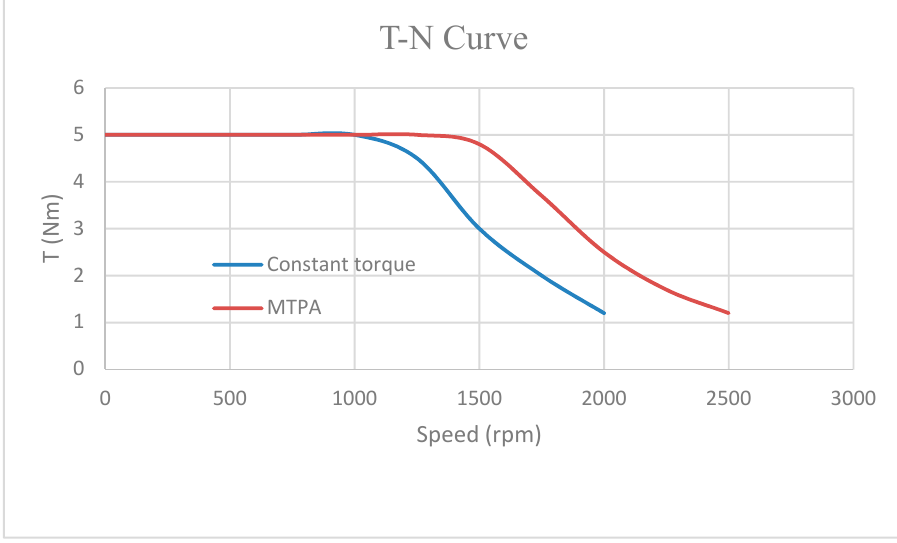
Figure 12. Torque–speed curves by fixed torque angle method and fuzzy MTPA/MTPV control.